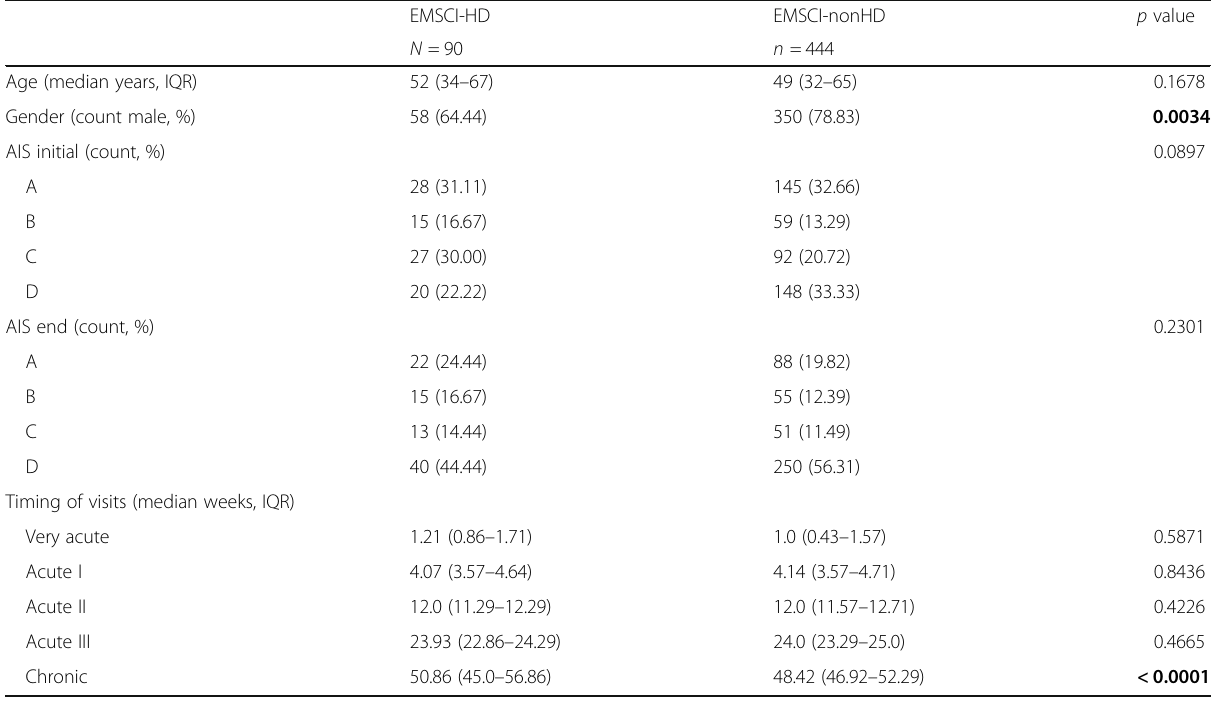
Table 1 Complete-case data set